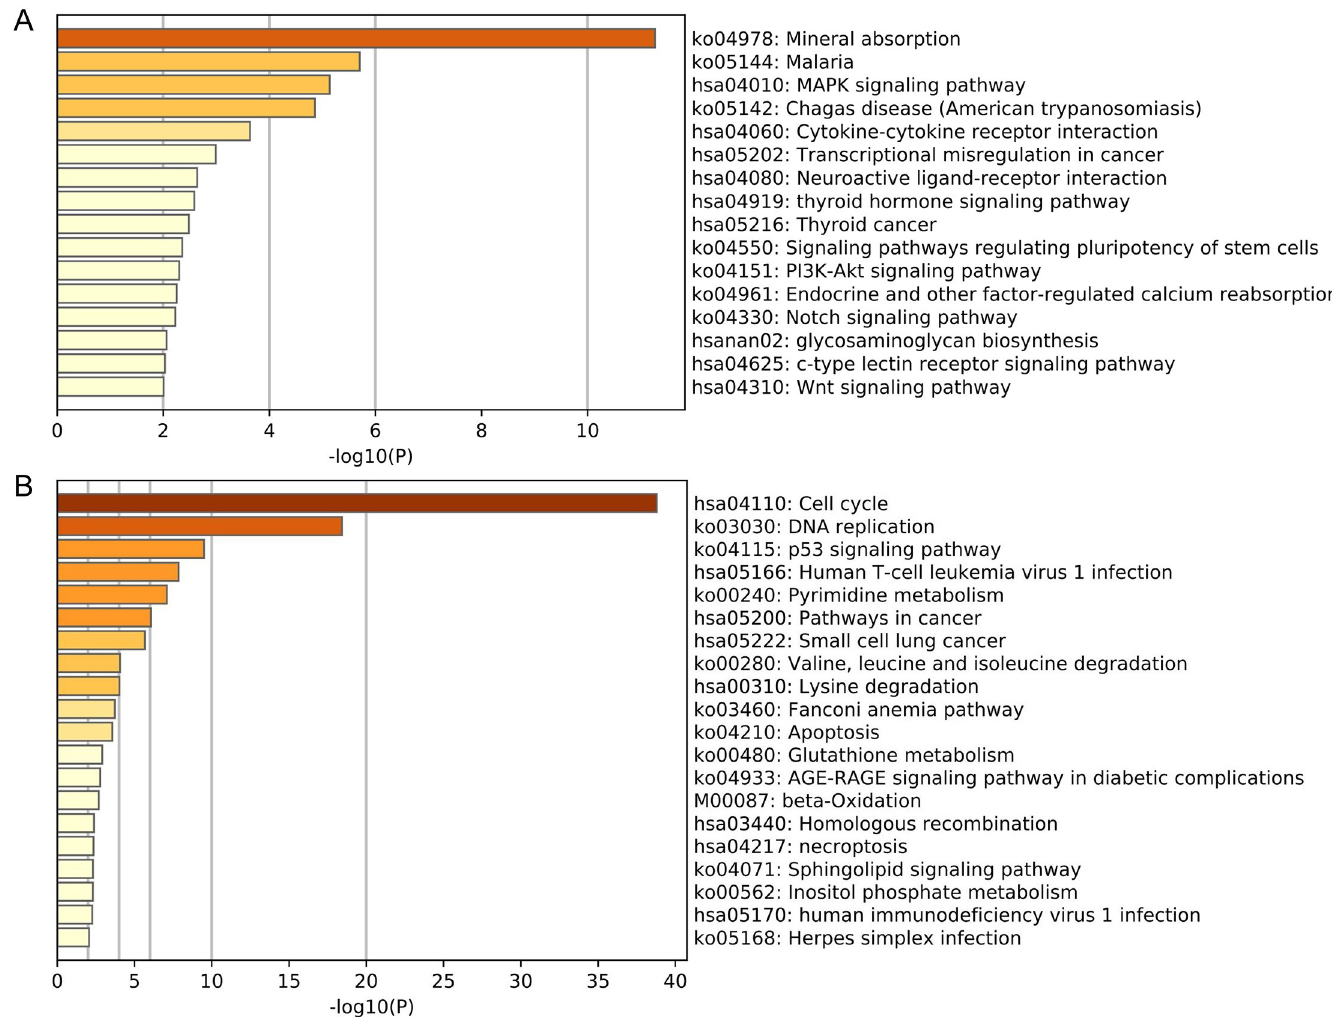
Fig 3. The core module mRNAs enrichment analysis. (A) The KEGG analysis of mRNAs involved in the magenta module. (B) The KEGG analysis of mRNAs involved in the yellow module.